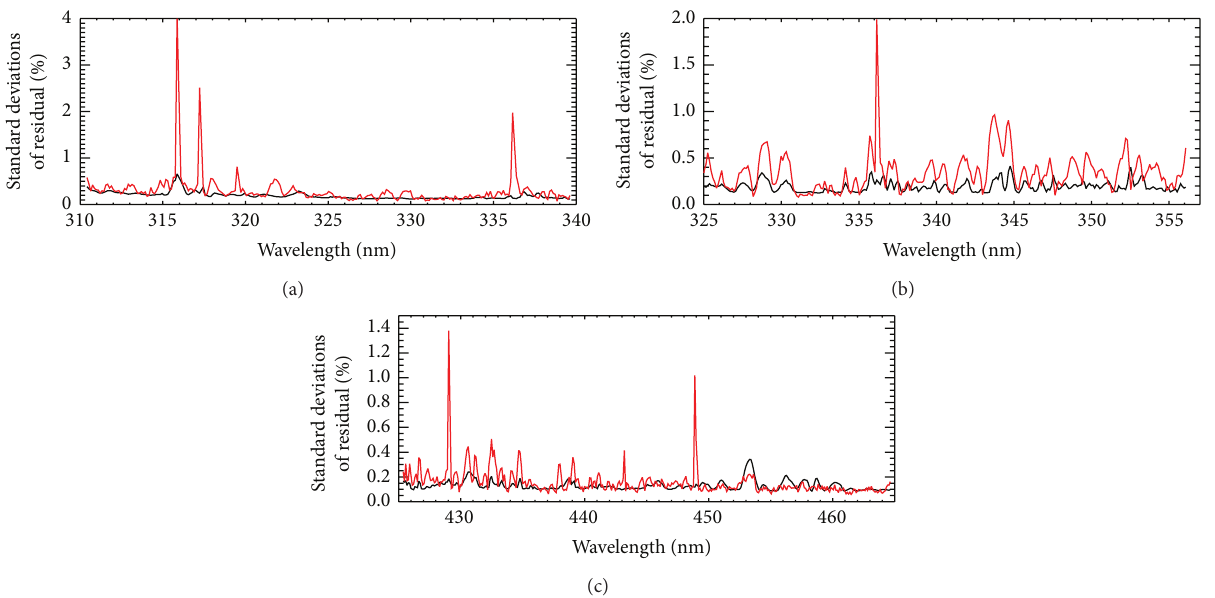
Figure 1: Standard deviations of fitting residuals from both zenith (red) and nadir (black) measurements of the ACAM AQ channel on July 21, 2011, for three selected wavelength ranges: (a) O 3 fitting window, (b) CH 2 O fitting window, and (c) NO 2 fitting window.